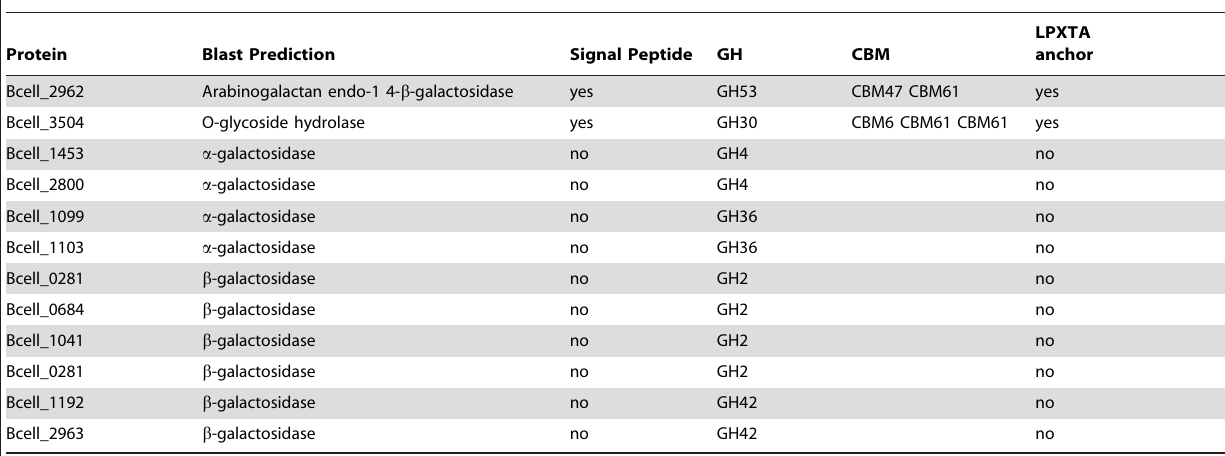
Table 8. Annotated Galactan-degrading Enzymes.